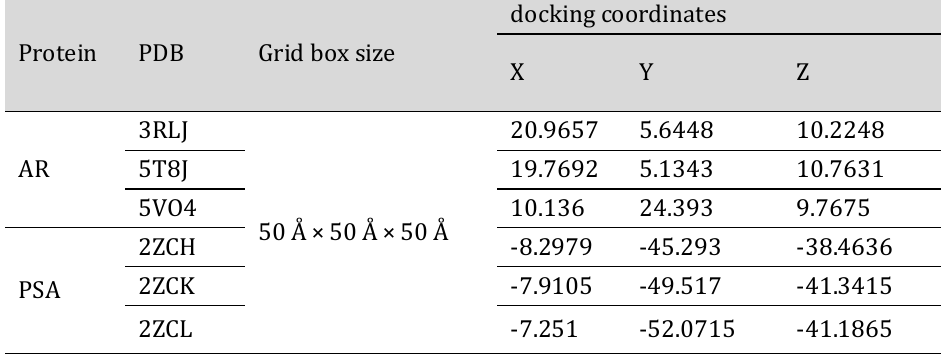
Table 1. Docking coordinates on the selected prostate cancer-related proteins